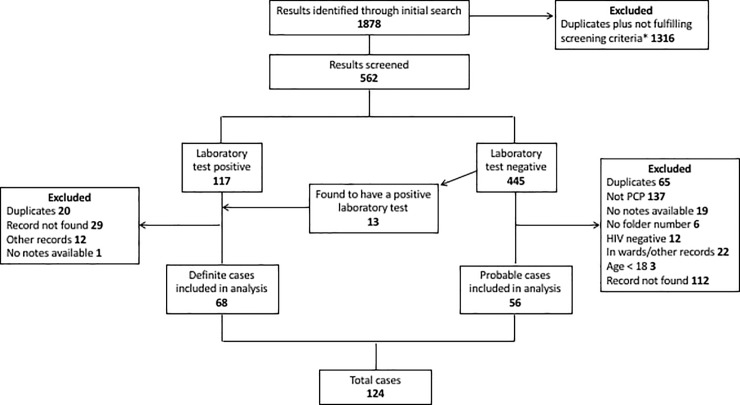
Consort diagram.* Criteria for screening records included: any positive test result, all patients with negative results from ICUs and high care units, laboratory request forms listing HIV infection or suspected PCP.